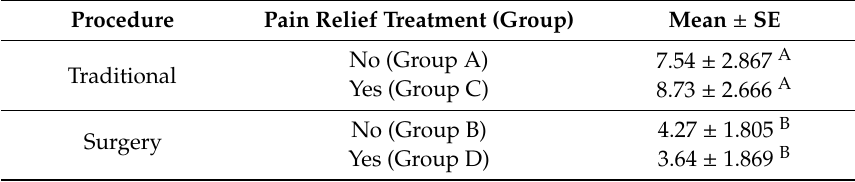
Table 2. Mean and SE of days free of signs of infection, following tail docking by “Surgery” (conducted under general anaesthesia with stitching; Groups B and D) or “Traditional” (conducted without general anaesthesia or stitching; Groups A and C), with or without treatment with PR (yes or no, respectively). A,B : di ff erent letter mean significant di ff erences between procedures ( p < 0.05).